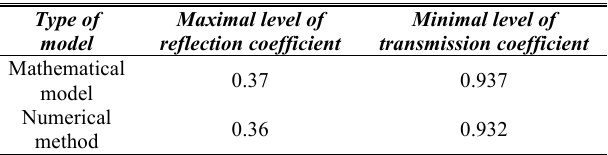
TABLE I. C OMPARISON OF THE ELECTROMAGNETIC PARAMETERS CALCULATED BY TWO METHODS FOR A WAVEGUIDE POLARIZER WITH A DIAPHRAGM AND PINS Type of